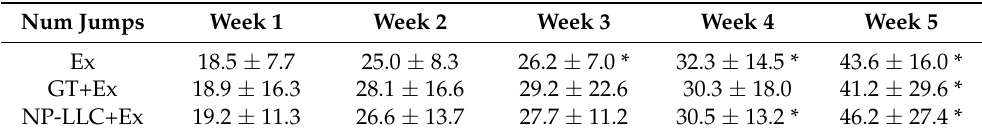
Table 2. Mean ± SD of the jumps of the animals under training, over the